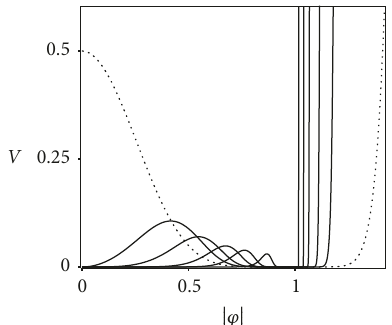
Figure 5: The potential in (41) for 𝛽 = 8 and several values of 𝑙 . The dotted line stands for the case 𝑙 = 1